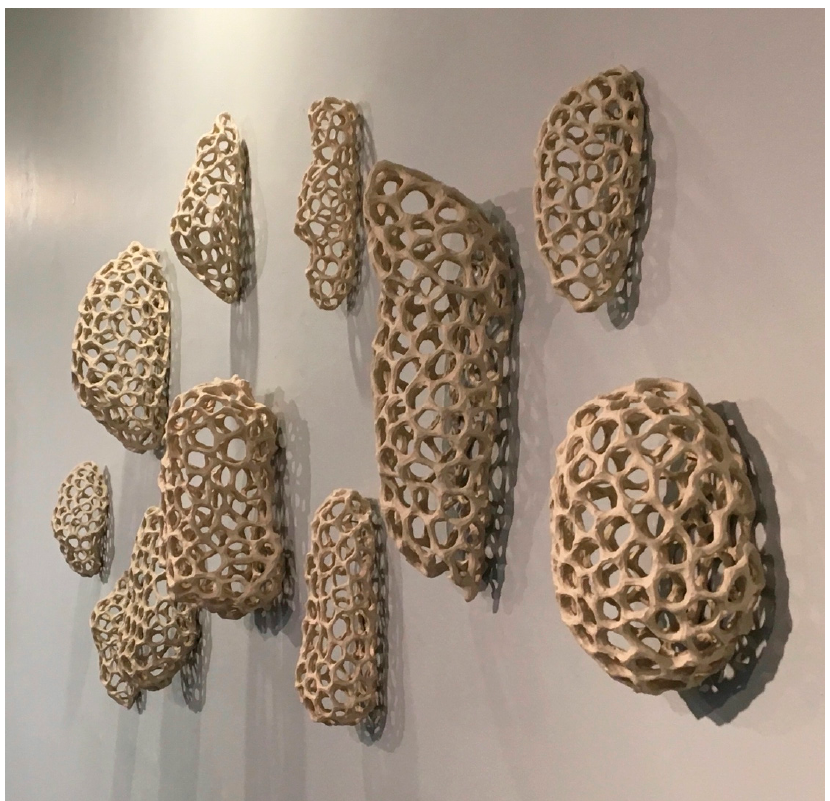
Figure 3. Yvonne Love. From the series “Breath,” exhibited at Brown University’s Gallery 221.